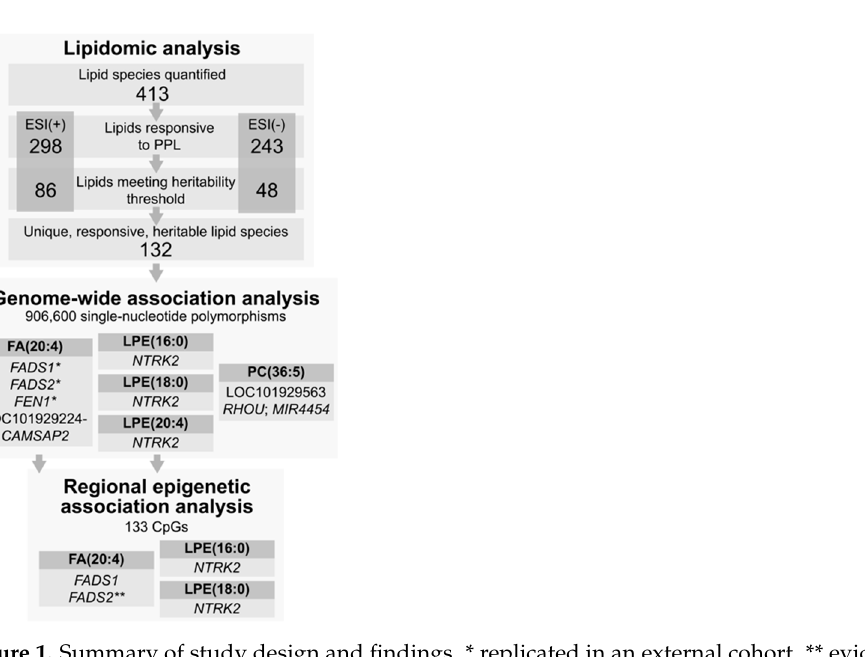
Figure 1. Summary of study design and findings. * replicated in an external cohort. ** evidence of partial mediation of SNP association by a CpG.